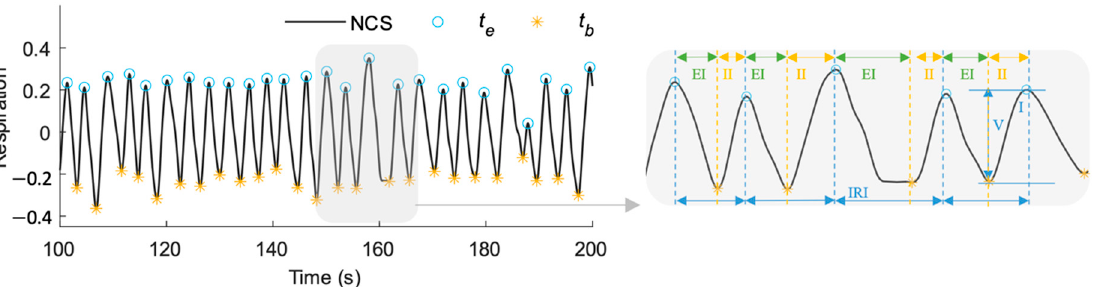
Figure 4. NCS respiration waveform showing different features. The maxima and minima